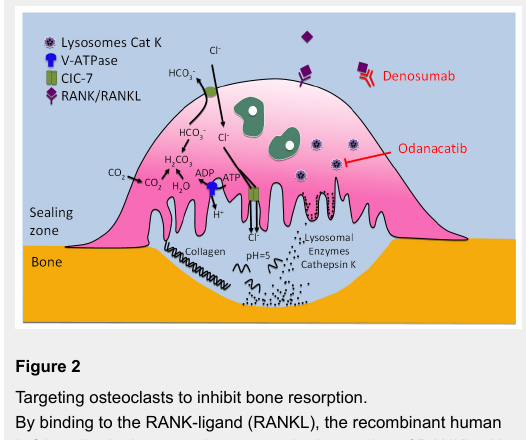
Targeting osteoclasts to inhibit bone resorption. By binding to the RANK-ligand (RANKL), the recombinant human IgG2-antibody denosumab prevents the interaction of RANKL with its receptor RANK, which leads to the inhibition of osteoclast formation, function, and survival, and to decreasing bone resorption. Odanacatib is an inhibitor of cathepsin K, a lysosomal cysteine protease with high collagenase activity expressed predominantly in osteoclasts, which may suppress osteoclast function without impairing osteoclast viability, thus preserving the osteoclast-osteoblast crosstalk and bone